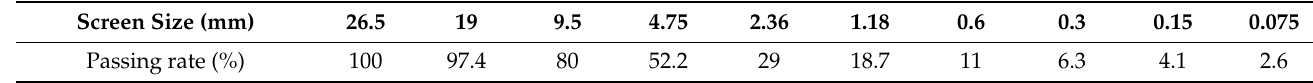
Table 1. Particle size distribution of the studied RAP.